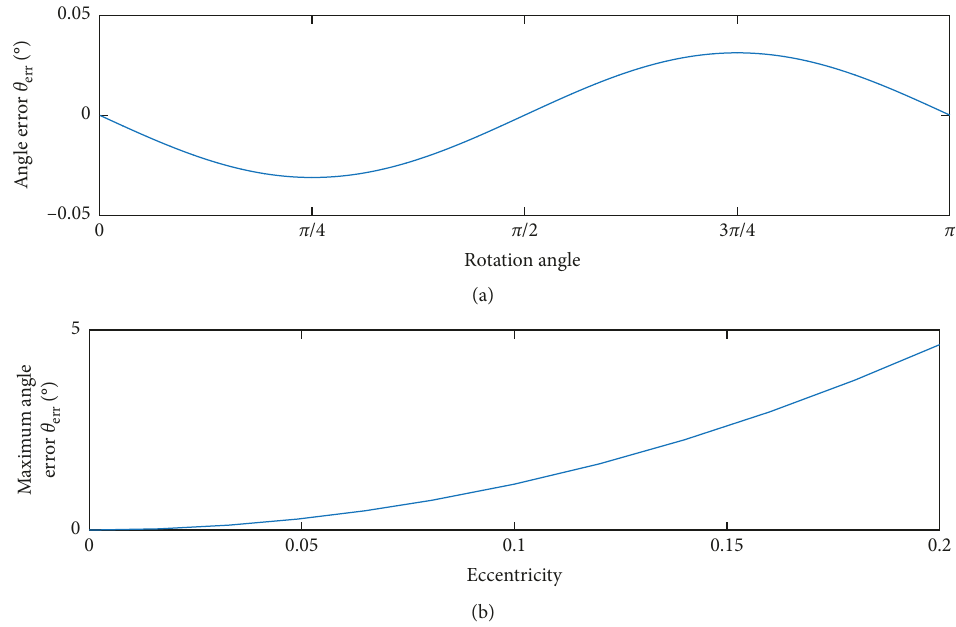
Figure 14: (a) Angle error θ err with rotation angle and (b) maximum angle error with